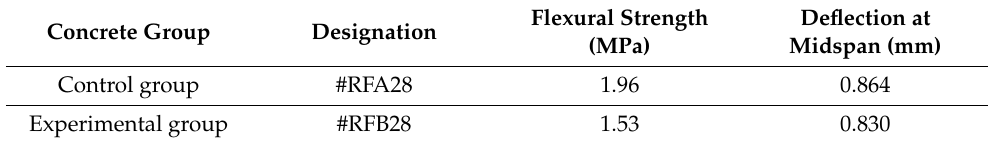
Table 19. Relative-flexural-strength ratios of the flexural failure specimens after self-healing.